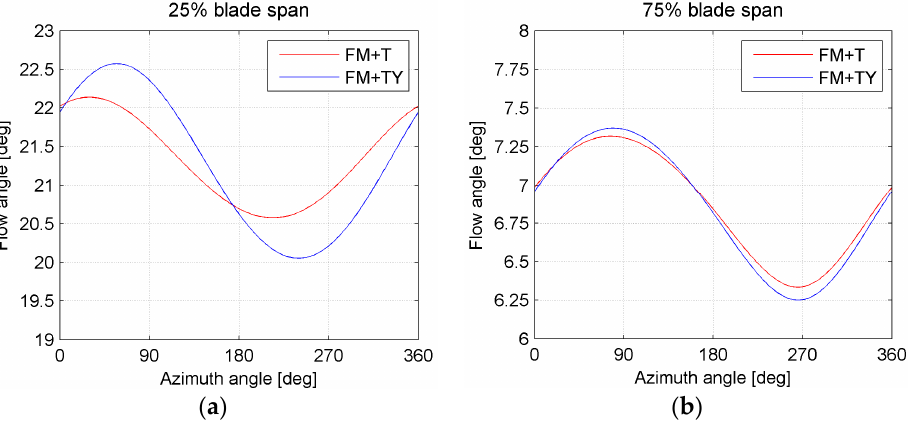
Figure 20. Computed flow angles at two different spanwise locations: ( a ) 25% and ( b ) 75% of the total span. Comparison between the FM + T and FM + TY configurations.